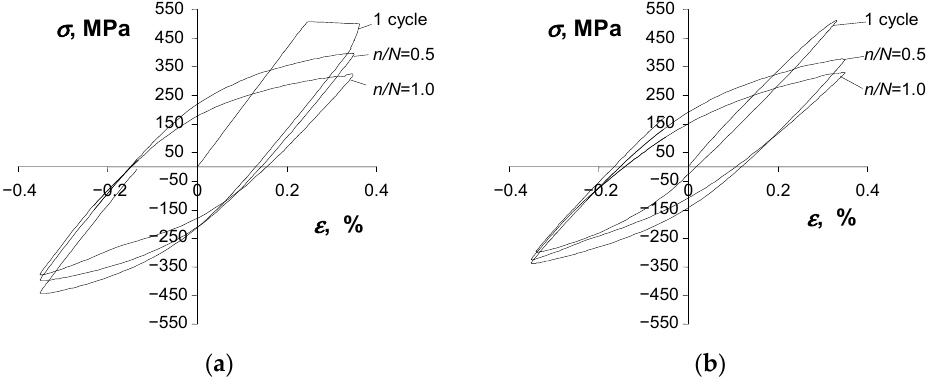
( b ) Figure 10. Changes in mean stress 𝜎 𝑚 versus number of cycle: ( a ) as-received specimens, ( b ) pre-strained specimens. The pronounced stress asymmetry during cyclic loading of pre-strained specimens can be attributed to the occurrence of the Bauschinger effect [32]. The pre-strain with a simultaneous exceeding of the yield strength in tension ( 𝜀 (cid:3028)(cid:3030) = 10%) resulted in a decrease in the yield strength in compression conditions and thus an increase in the mean stress